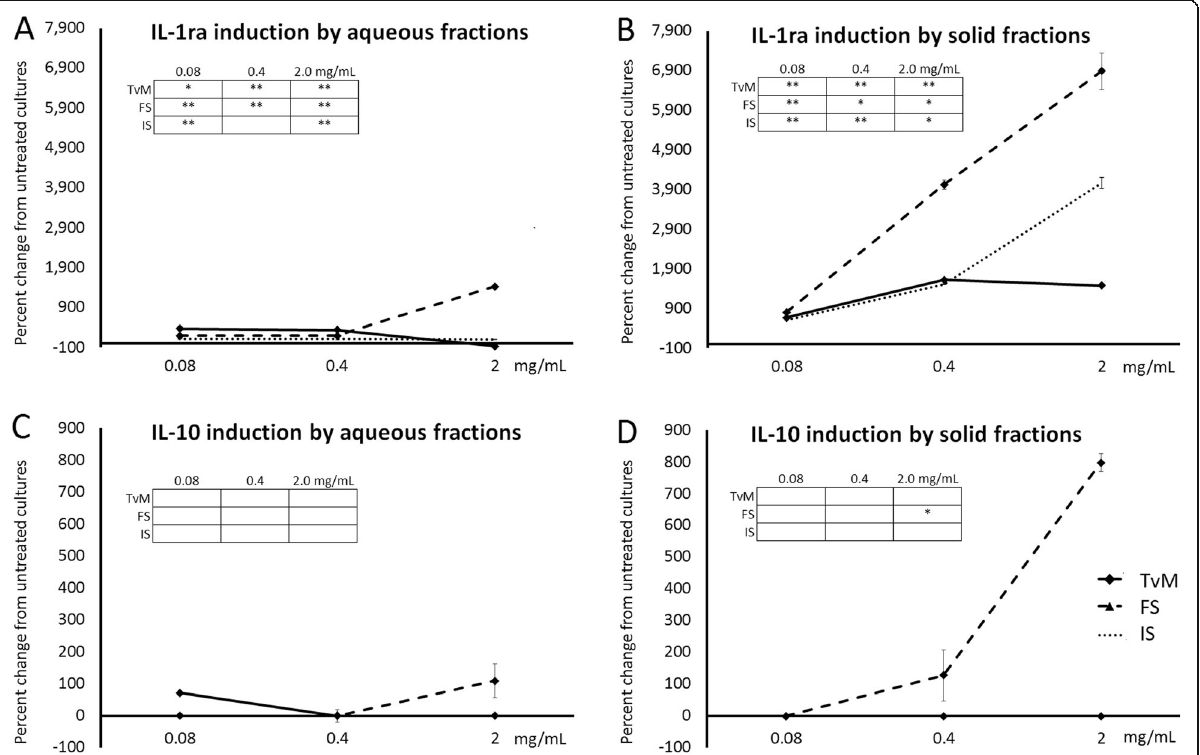
Fig. 7 Changes in levels of the cytokines Interleukin-1 receptor antagonist (IL-1ra) and Interleukin-10 in supernatants from human PBMC cultures. The PBMC were cultured for 24 h in the presence of serial dilutions of Trametes versicolor mycelium (TvM), fermented substrate (FS), or initial substrate (IS). The effects on IL-1ra and IL-10, both involved in anti-inflammatory processes as part of the resolution of inflammatory processes, of aqueous extracts are shown in a and c , and of the solid fractions are shown in b and d . Data are shown for three doses (0.08, 0.4, and 2 mg/mL), where the doses represent the amount of starting material used to produce a given fraction. Data are presented as mean ± standard deviation of the percent change seen in triplicate cultures, and represents one of three separate experiments using PBMC cells from three different healthy human donors. Inserted tables: Statistical significance is indicated as * for P < 0.05 and ** for P <